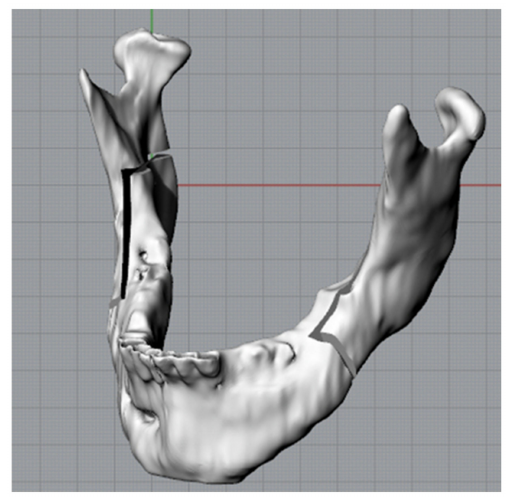
Figure 1. Bilateral sagittal split